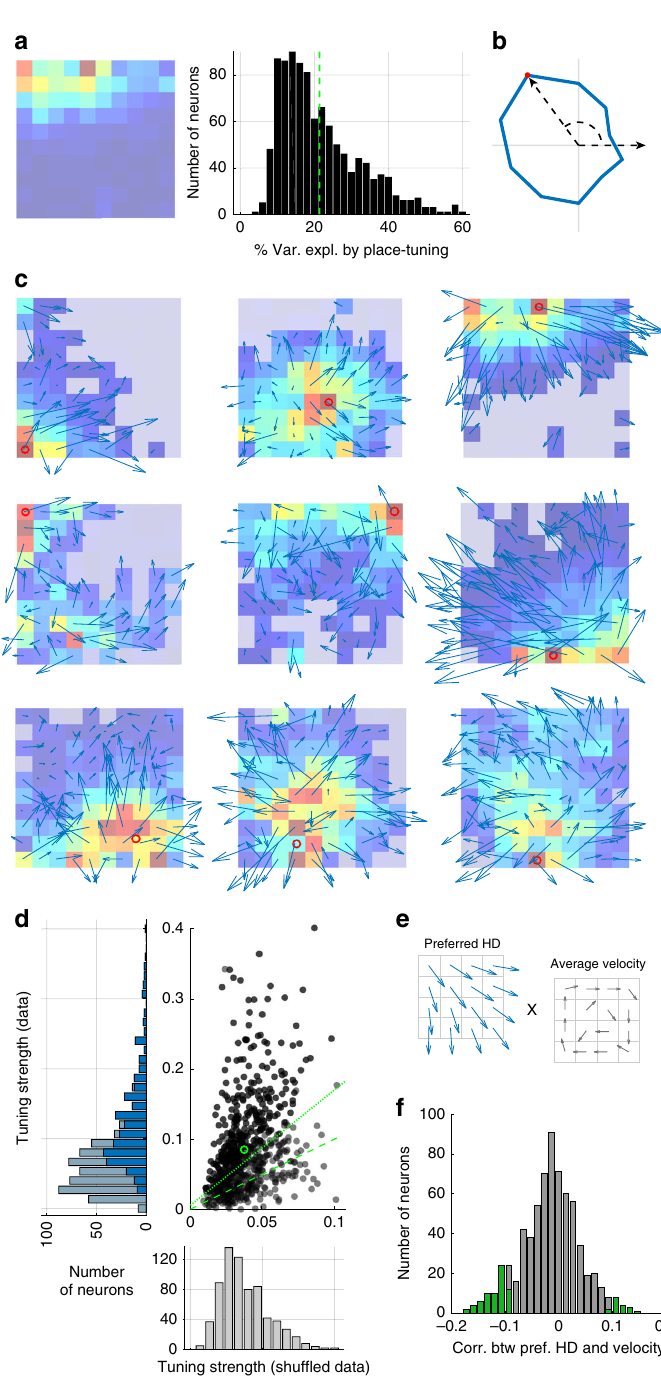
Fig. 1 Heading-direction (HD) modulation. a Firing rate as a function of location for a typical place cell (left). Firing rate range for spatial map in spikes per second (Hz) is 0 – 13.8. Colors from blue to red indicate low to high fi ring rates. (right) Percentage of variance explained by location tuning across neurons. b Example of HD tuning in one neuron. Radius of curve is proportional to the fi ring rate for each angular bin. Maximum fi ring rate for angular dependency 3.2 (Hz). c Head-direction tuning of fi ring rates shown as rate-weighted sums of HD vectors within each bin. Place fi elds are also shown, as in a. Firing rate ranges for each spatial map are 0 – 9.5, 0 – 5.2, 0 – 13.8; 0 – 5.9, 0.1 – 28.5, 0 – 8.8; 0.1 – 10.4, 0 – 7.8, and 0 – 8. Red circles are the centers of mass of the place fi elds. Light-blue squares denote bins with average fi ring rates too low to be included in the analysis of directional modulation. d Average tuning strengths of HD modulation across bins for actual and randomly reshuf fl ed data. Green circle denotes the means of each distribution. Neurons that have average HD modulation higher than the 95% con fi dence of the shuf fl ed data angular modulation are above the dotted green line (dashed green line is the diagonal); 78% of the neurons are above the equality line (dashed line), and 46% are above the 95% con fi dence line (dotted line). Histogram of neurons with tuning strength for all neurons and for neurons above 95% con fi dence interval in light and dark blue bars, respectively. e Schematics of preferred HD vectors (left) and average velocity vectors (right) for each spatial bin. f Distribution of the correlation between preferred HDs (pref. HD) and the velocity of the animal ’ s motion for actual and shuf fl ed data. Only 13.4% of neurons, indicated by green, have signi fi cant correlation between neural response and direction of motion (5% is